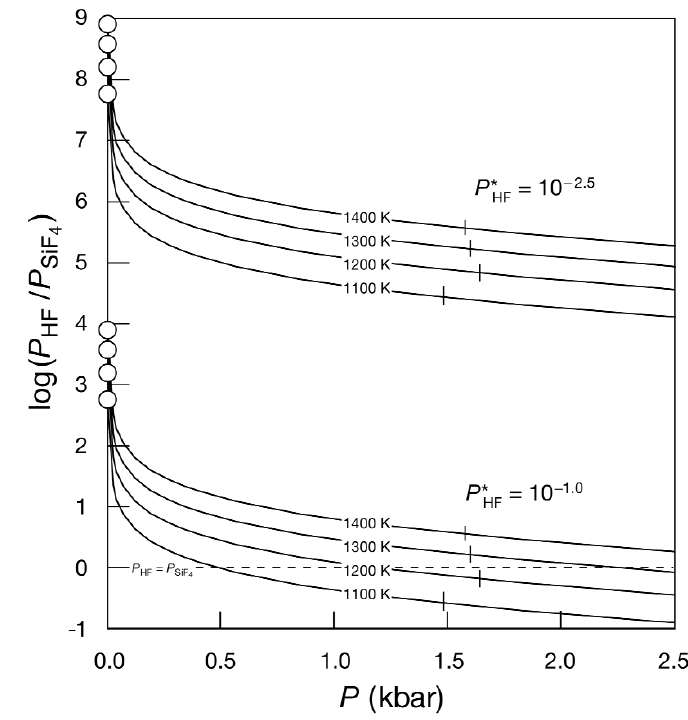
Fig. 3. Variation of log ( P HF / P SiF ) with total pressure for various temperatures at P * HF = 10 − 2.5 and P * HF = 10 − 1.0 , 4 respectively. The importance of SiF 4 increases with decreasing temperature, increasing P HF , and increasing pres- sure. The circles represent data at 1 bar, and are equivalent to the values in fig. 2 at the same temperature and P * HF